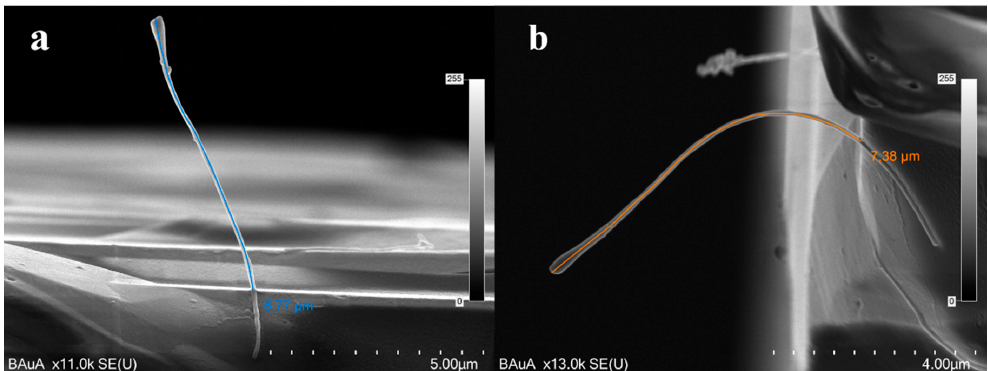
Figure 6. SEM images of the length determined from two different projections of the same MWCNT: ( a ) the front view gives a value of 6.77 µm and ( b ) the side view shows a visibly higher length of 7.38 µm. The in-image measurements were performed with the software Olympus IMS.